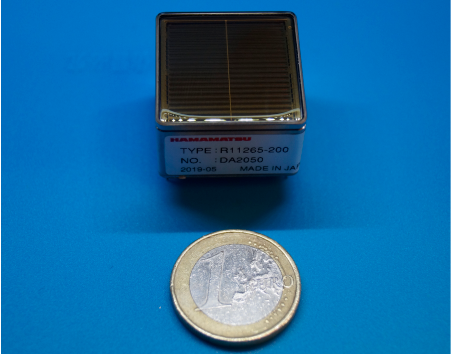
Figure 7. The R11265-200 PMT manufactured by